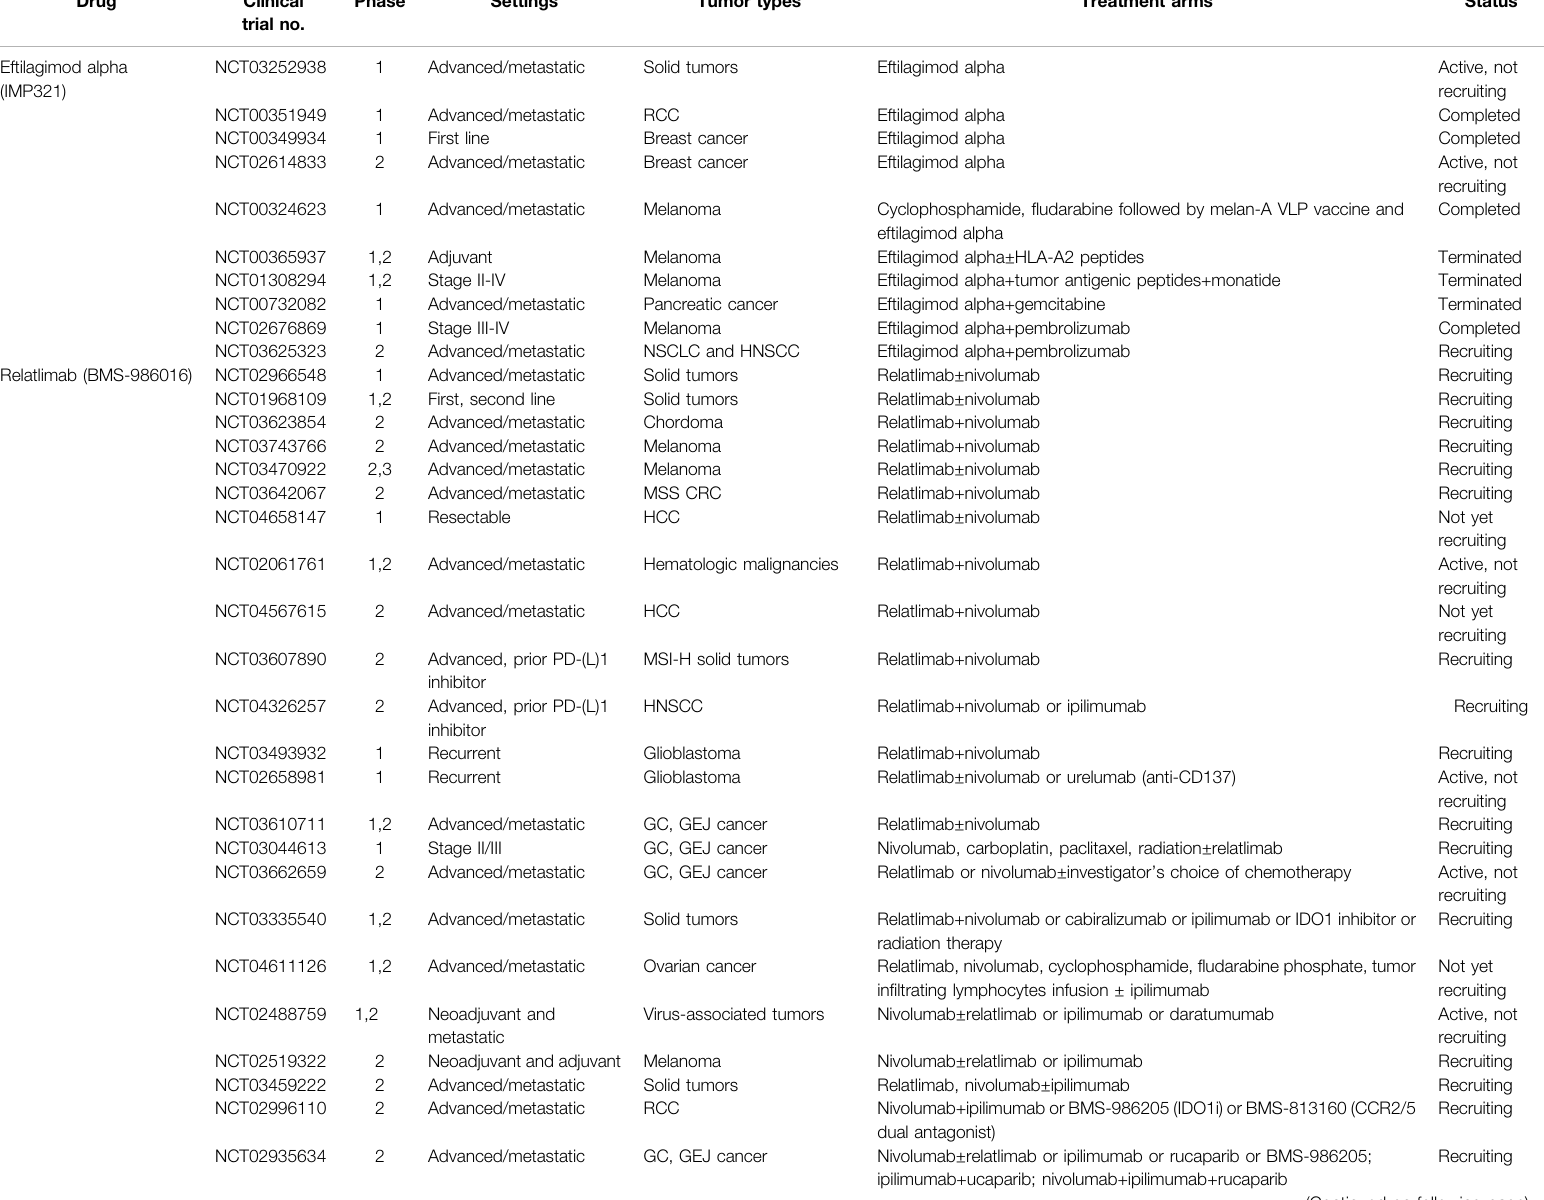
TABLE 3 | Clinical trials on novel immune checkpoint inhibitors. Target